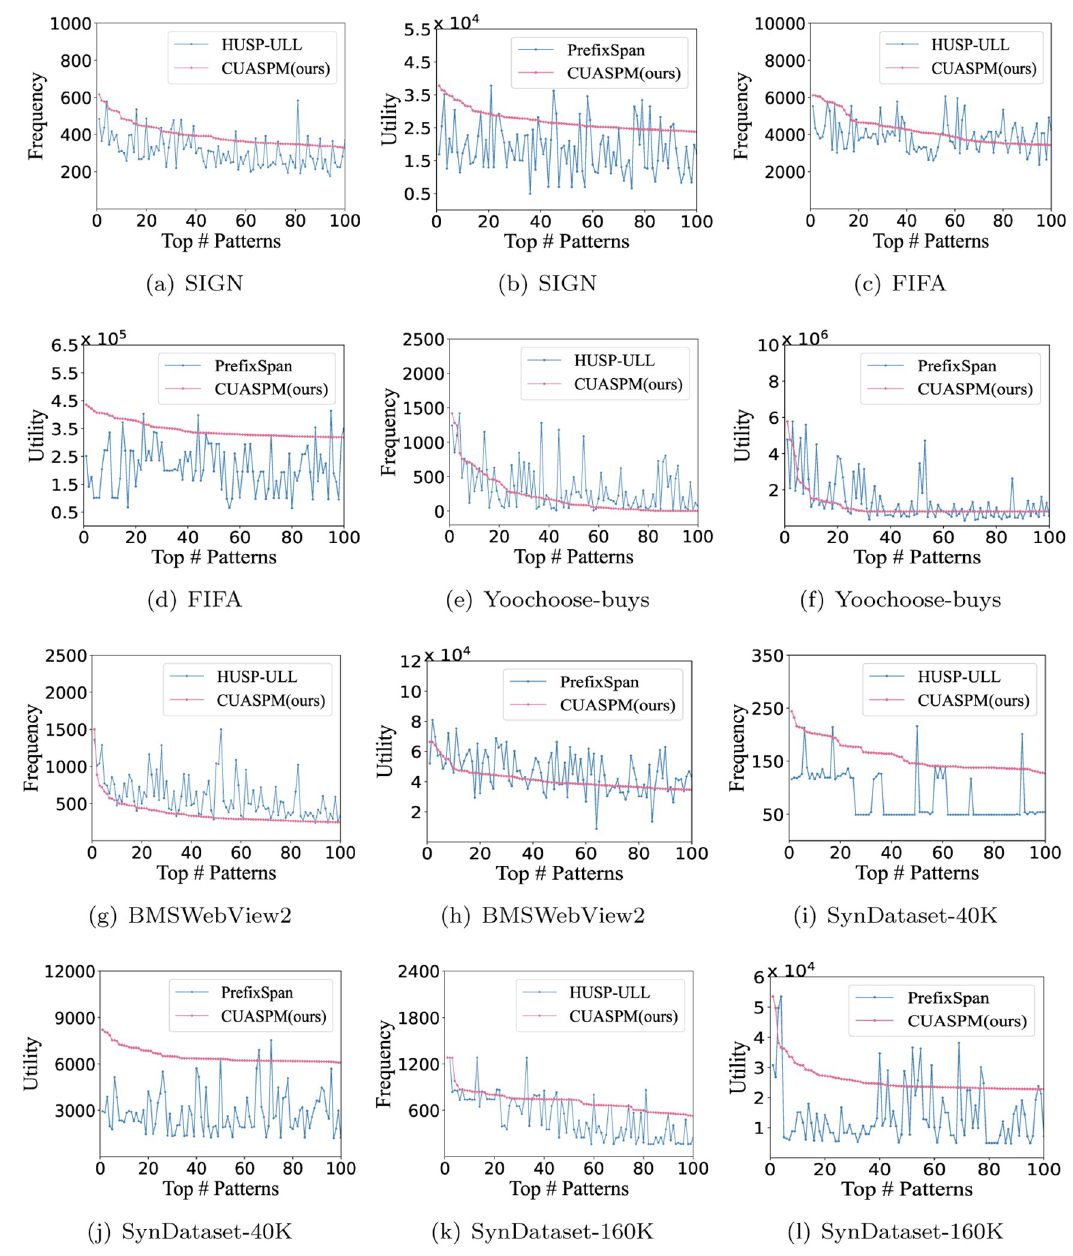
Fig 8. Experiments for FSs, HUSPs and ACHUSPs with I 1 = 0.01. (a) SIGN, (b) SIGN, (c) FIFA, (d) FIFA, (e) Yoochoosebuys, (f) Yoochoose-buys, (g) BMSWebView2, (h) BMSWebView2, (i) SynDataset-40K, (j) SynDataset-40K, (k) SynDataset-160K, and (l)